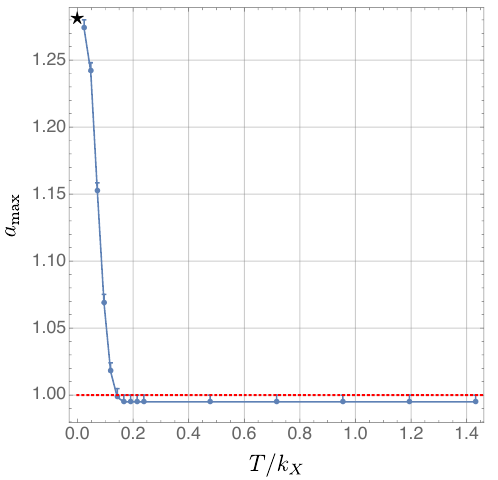
Figure 20 . a max as a function of T=k X . The black star is the T = 0 result obtained in the previous section and the dotted red line is a = a ergo =